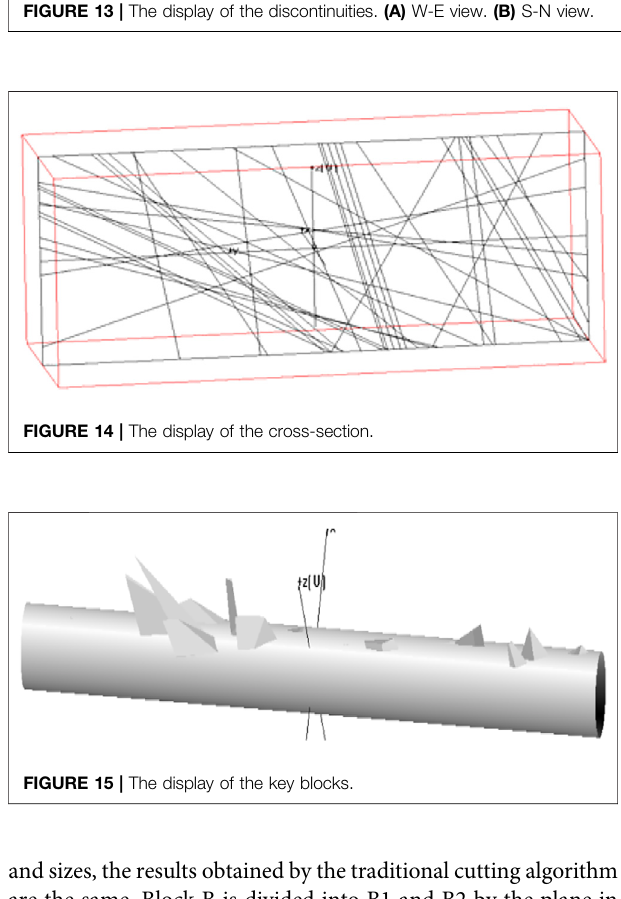
FIGURE 13 | The display of the discontinuities. (A) W-E view. (B) S-N view.